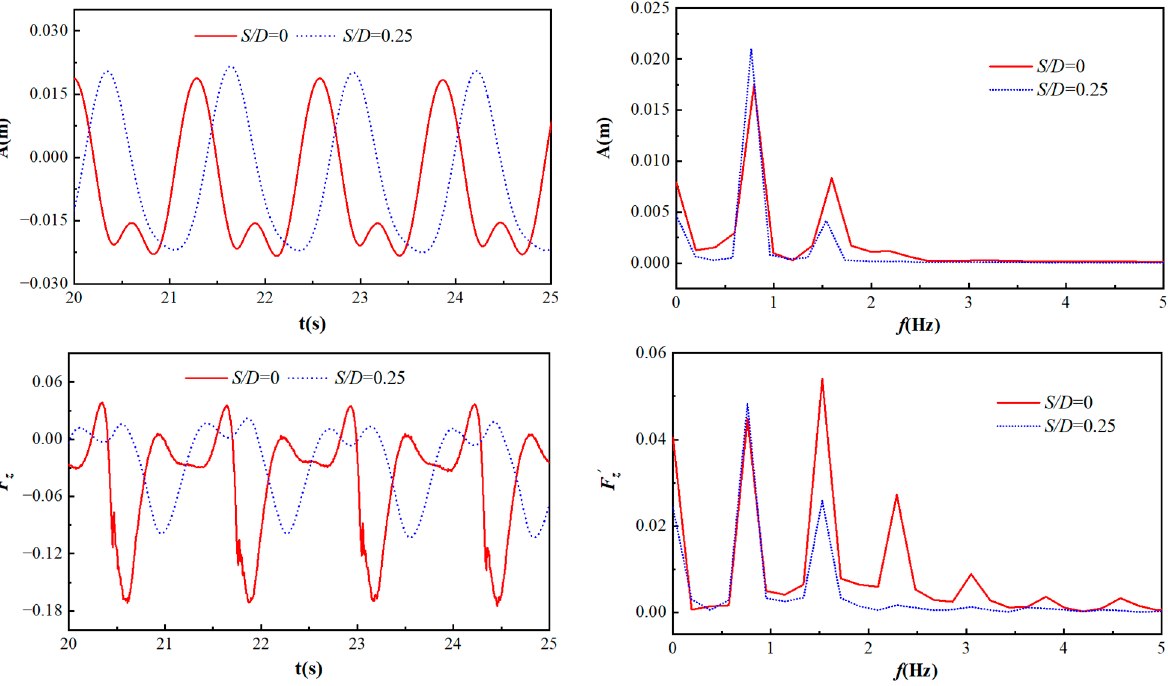
Figure 16. Time series curve and spectrum of wave–current force on cylinder under different submerged depths.